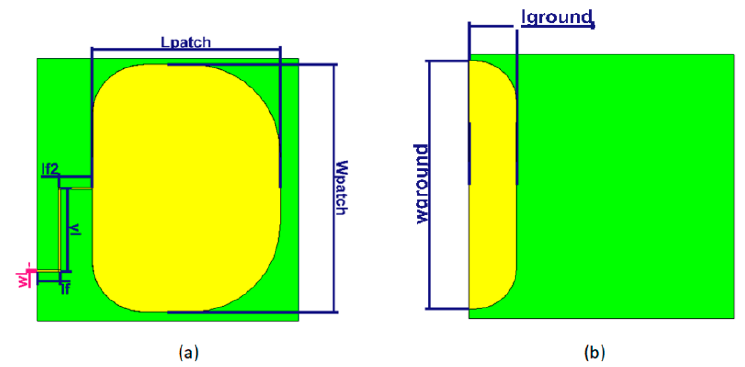
Figure 7. Configuration of the proposed antenna: ( a ) Top view; ( b ) Bottom view.